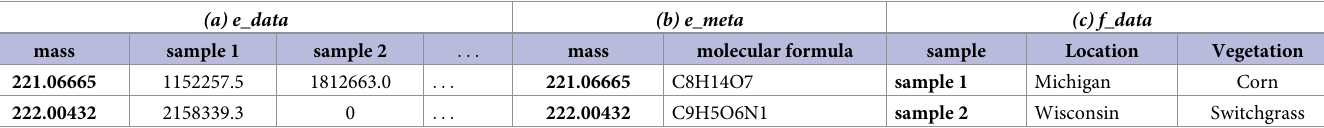
Table 1. Example format of required input data.frames for ftmsRanalysis package showing the first few rows and columns of each. (a)